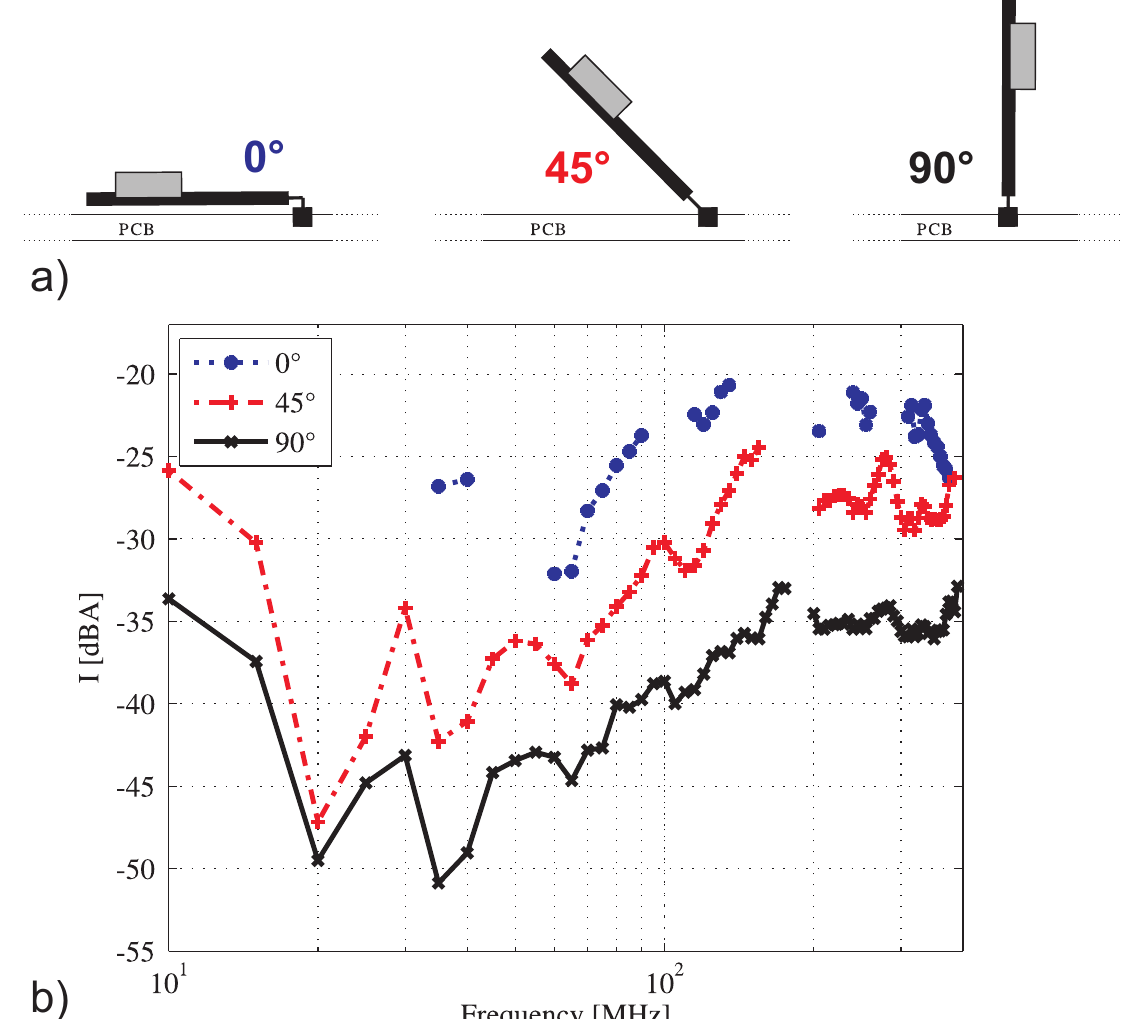
Figure 10. ( a ) Hall sensor inclination considered in BCI tests; and ( b ) respective BCI immunity